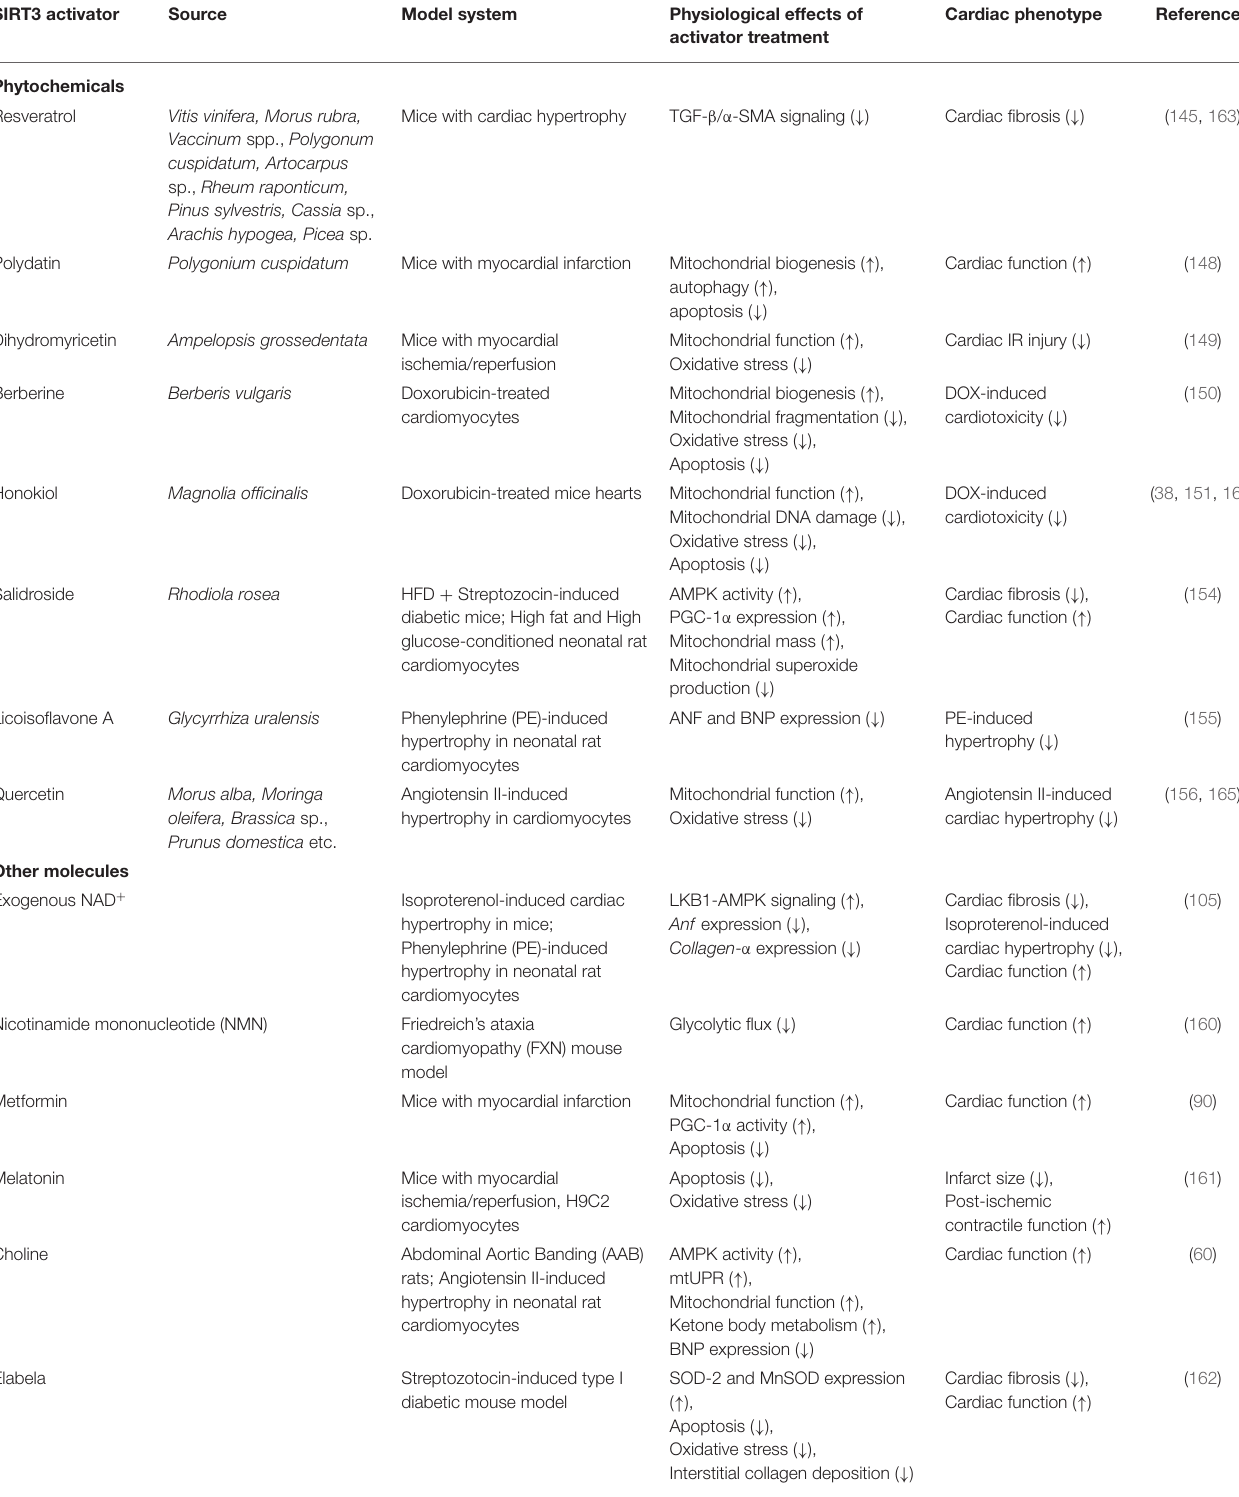
TABLE 3 | Activators of